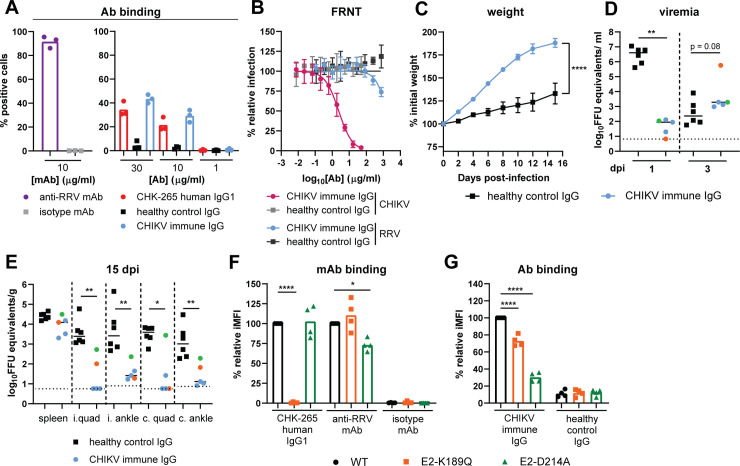
Cross-reactive CHIKV immune polyclonal IgG protects against RRV-induced disease despite emergence of RRV variants in the E2 B domain.(A) 293T cells were transfected with the RRV structural genes, stained using CHK-265 human IgG1, CHIKV immune IgG, or IgG isolated from healthy controls (healthy control IgG), and analyzed by flow cytometry. An anti-RRV mAb (RRV-130; 10 μg/ml) and human isotype control (WNV hE16; 10 μg/ml) were included as positive and negative controls, respectively. (B) Neutralization assay. Purified polyclonal CHIKV-immune IgG was preincubated with 102 FFU of RRV or CHIKV-LR then added to Vero cells for 20 or 18 h, respectively. Viral foci were counted and compared to wells without mAb to determine relative infection. Purified IgG from healthy individuals (healthy control IgG) was included as a negative control. (C-E) Three-week-old male and female WT mice were administered 300 μg of purified human CHIKV immune IgG or healthy control IgG one day prior to infection with 103 FFU RRV. (C) Weights were followed for 15 dpi. Graph shows mean ±SEM (n = 5–6 per group; two experiments; student’s t-test of AUC analysis: ****P < 0.0001). (D) Serum was collected 1 and 3 dpi and titered by qRT-PCR. (E) Viral RNA was quantified from spleen, ipsilateral (i.) and contralateral (c.) quadriceps muscles (quad), and ipsilateral and contralateral ankle at 15 dpi using qRT-PCR. (D-E) Bars represent the median (n = 5–6 per group; two experiments; Mann-Whitney test; *P < 0.05, **P < 0.01). Colored circles indicate CHIKV immune IgG treated mouse with identified RRV variant at 3 dpi: orange circle: E2-K189Q mutation; green circle: E2-D214A mutation. (F, G) 293T cells were transfected with the WT, E2-D214A, or E2-K189Q RRV structural genes, stained with (F) CHK-265 human IgG1, anti-RRV mAb [RRV-130; 0.04 μg/ml (EC80)], human isotype control (WNV hE16), (G) CHIKV immune IgG, or healthy control IgG at 30 μg/ml unless otherwise noted, and analyzed by flow cytometry. Relative integrated mean fluorescence intensity (iMFI) was calculated by multiplying the percent positive cells and the median fluorescence intensity for each RRV variant and comparing it to the RRV WT control. Bars indicate mean (four experiments performed in duplicate; One-way ANOVA with a Holm-Sidak’s post-test comparing RRV variants to WT; *P < 0.05, ****P < 0.0001). Ab: antibody.